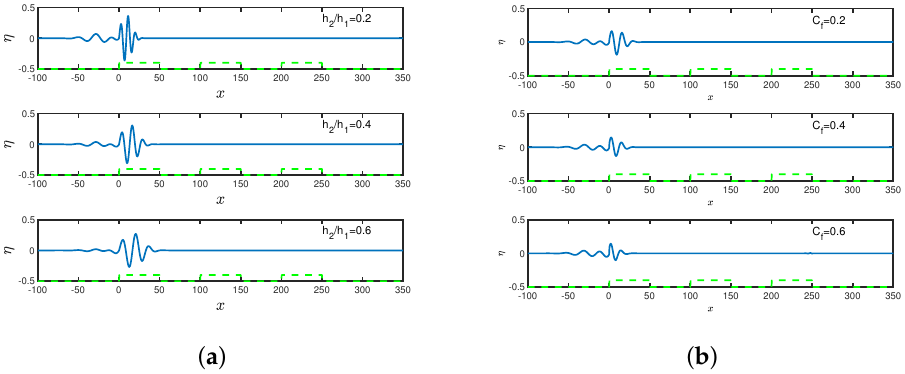
Figure 15. Free surface elevation η ( x , t ) versus x for different ( a ) breakwater depth h 2 / h 1 without friction coefficient C f = 0 and ( b ) friction coefficient C f with h 2 / h 1 = 0.4 with h 1 = 5 m, N = 3, t = 2 s, θ = 30 ◦